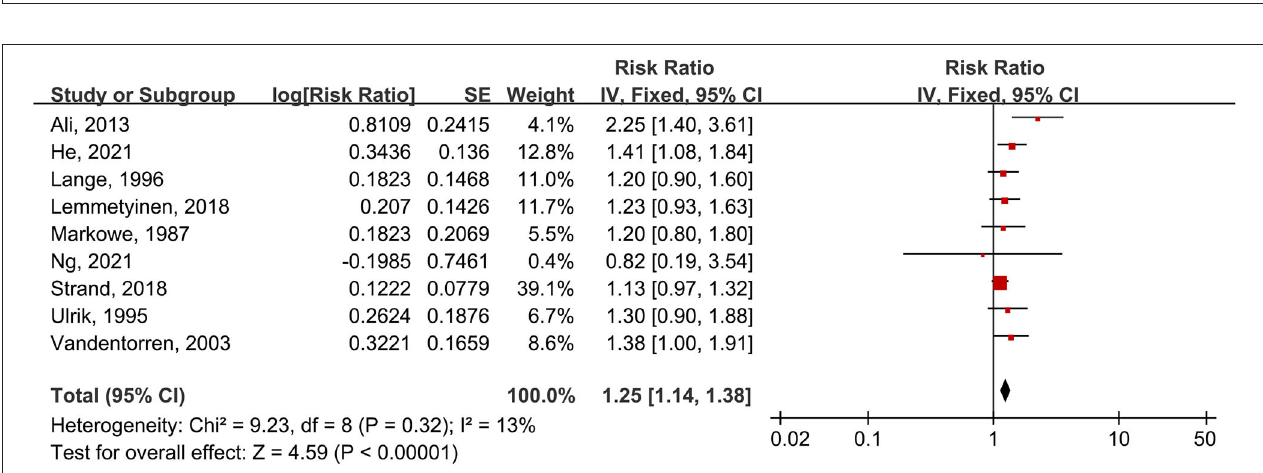
FIGURE 6 | Forest plot shows association between asthma and CVD morbidity in male and female asthma patients. SE, standard error; IV, Inverse Variance method; df, degrees of freedom; a/f, adult female; a/m, adult male; c/f, child female; c/m, child male.